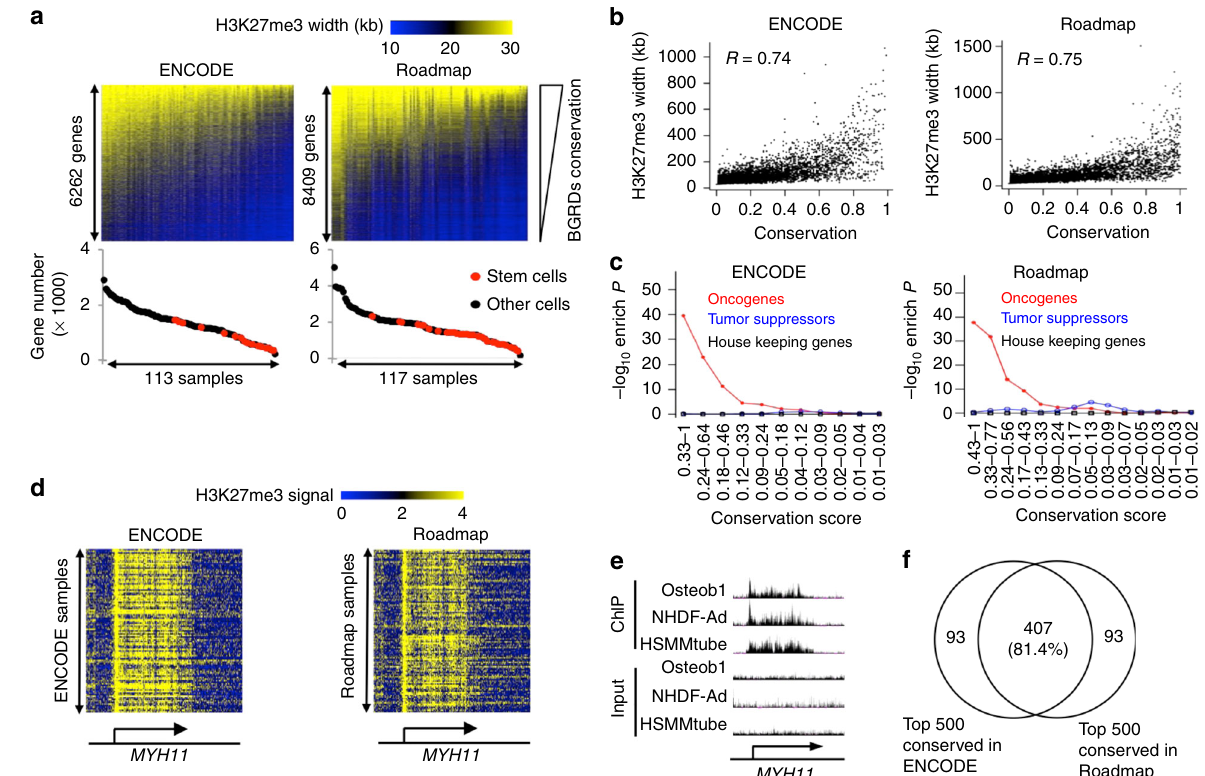
Fig. 4 BGRDs at oncogenes are conserved across normal cell and tissue types. a Heatmaps to show BGRD width values at 6262 genes (rows) across 113 ENCODE cell samples (columns) (top left panel) and 8409 genes across 117 Roadmap tissue and primary cell samples (top right panel). Presented are genes associated with BGRDs in at least one sample in each heatmap. Genes were ranked by BGRD conservation level de fi ned as the proportion of samples in which the BGRD was observed. Samples were ranked by number of BGRDs. Numbers of genes associated with BGRD in individual samples were plotted below the heatmap. b BGRD maximum width plotted against conservation level in ENCODE cell lines (left) and Roadmap tissues and primary cells (right). Pearson correlation coef fi cient was indicated on top. c The enrichment levels of each gene category plotted against conservation level of BGRDs. Genes were ranked by conservation level of BGRDs and divided into groups that each contains 1500 genes, with two neighboring groups in the rank having 500 genes in common. A dot in each curve indicates the enrichment level ( Y -axis) of one of these groups (range of conservation score indicated on X -axis) in the oncogenes, tumor suppressor genes, or housekeeping genes as indicated by the color legends. d Heatmaps to show H3K27me3 signal values at individual base pairs (columns) around TSS of the oncogene MYH11 across ENCODE and Roadmap samples (rows). Arrows indicate gene loci. Gene names were indicated at the bottom. e H3K27me3 ChIP signal and matched input background signal at the MYH11 gene region in three example cell lines. Arrow indicates gene loci. Gene name indicated at the bottom. f Venn diagram to show the overlap between genes that are associated with the 500 most conserved BGRDs in the ENCODE samples and in the Roadmap samples. P values determined by one tail Fisher ’ s exact test c . Spearman correlation coef fi cients were indicated b . Source data are provided as a Source Data fi